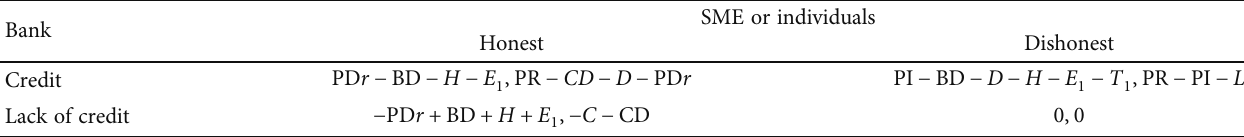
Table 2: Game matrix.